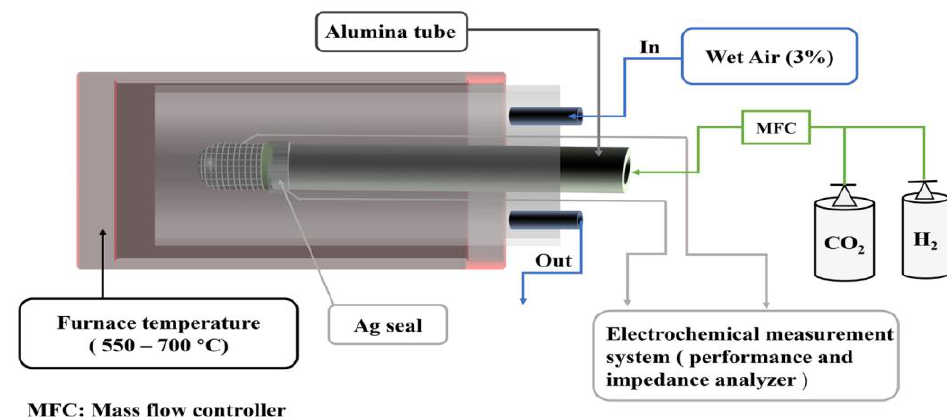
Figure 7. Schematics of the electrochemical test.